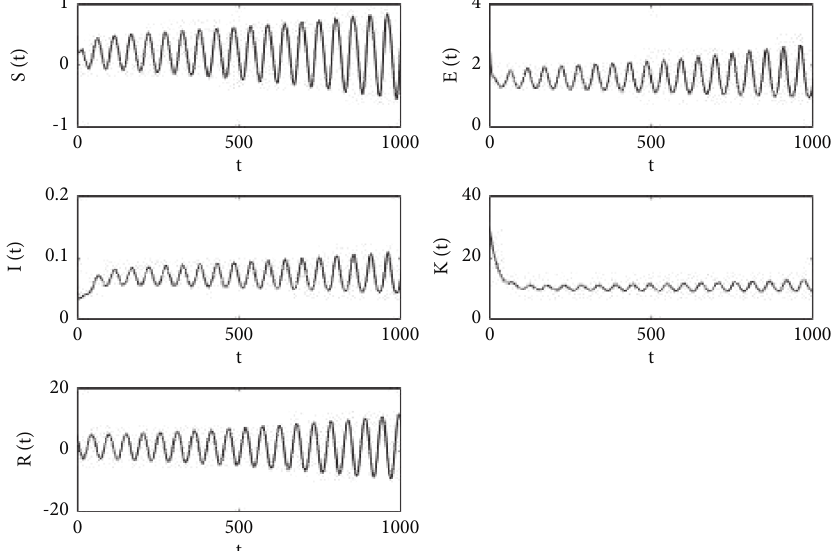
� 17 > τ , the equilibrium (0.5941, 2.2161, 0.0730, 14.3346, 2.7823) is not 1 10